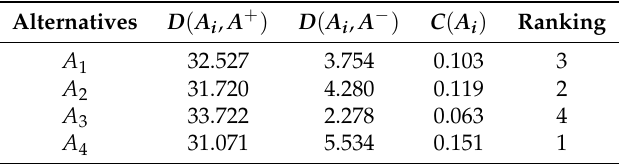
Table 9. Results obtained by the Ye’s method [34].